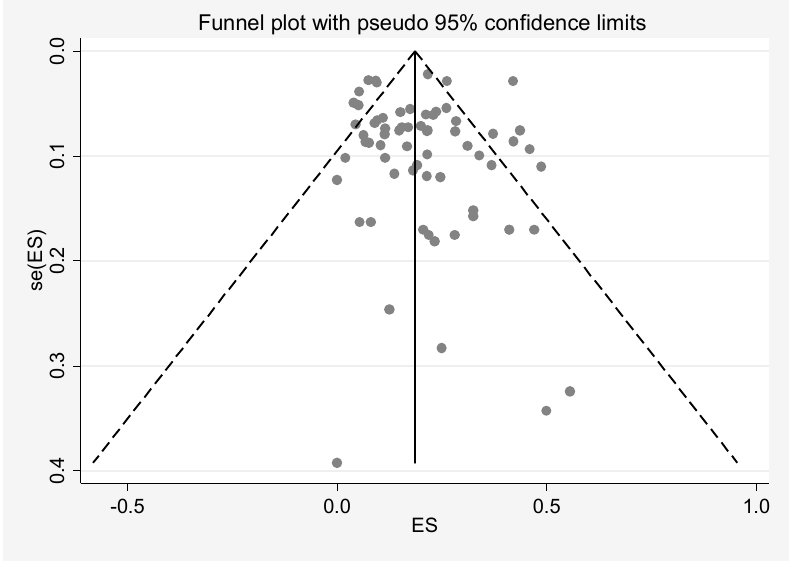
= E ff ect size estimate